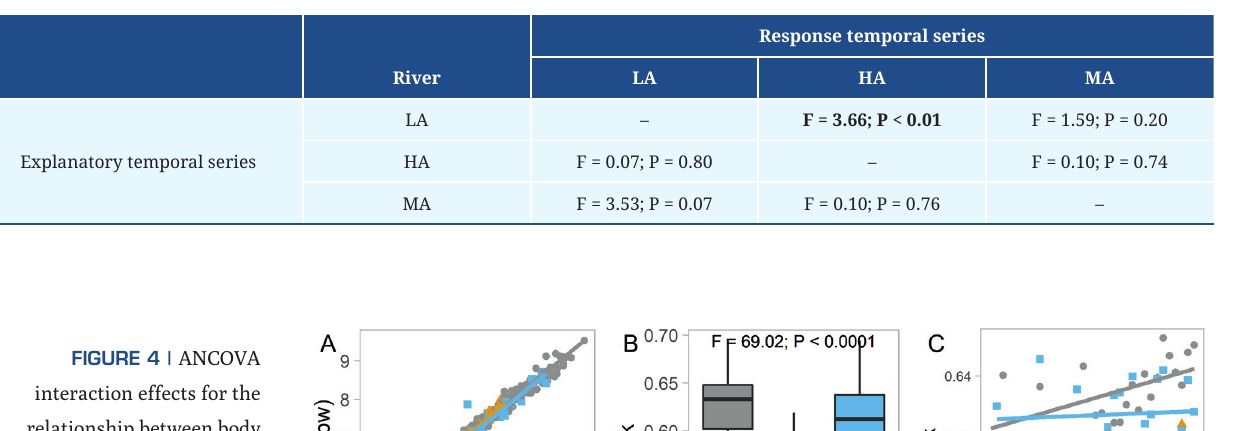
TABLE 1 | Granger test of causality. The upper row shows if the abundance in the HA – highly altered (Paraná River) and MA – moderately altered (Baía River) rivers have a causal relation with the abundance in the LA – less altered (Ivinhema River). The lower diagonal shows the inverse direction in causality. Bold letters indicate significant